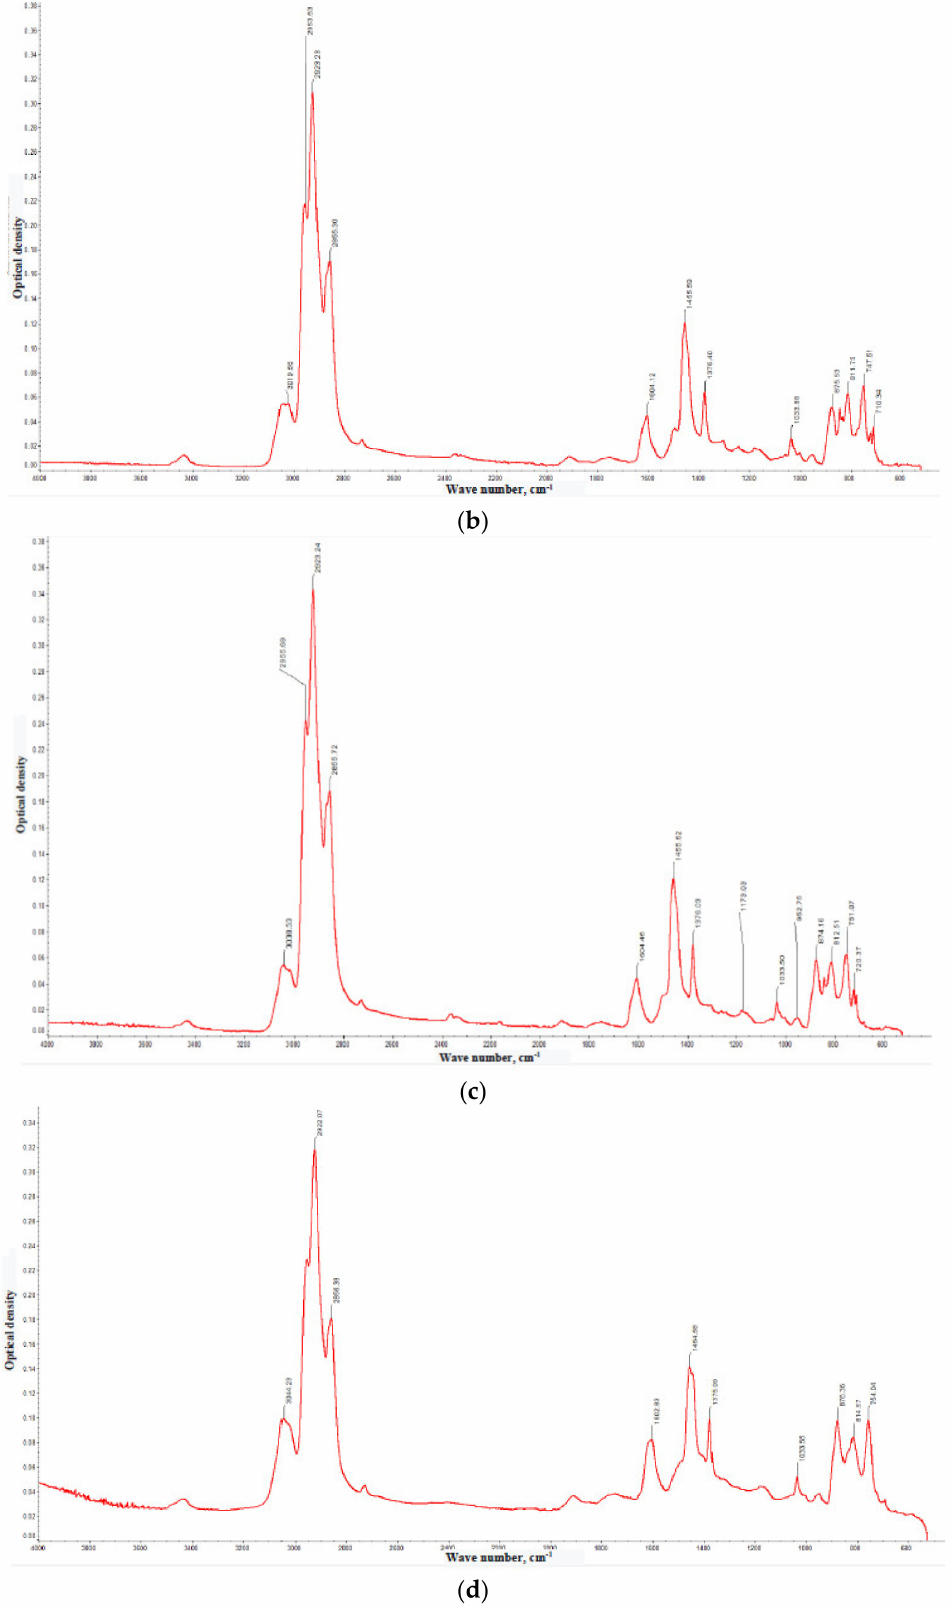
Figure 3. IR spectra of the gasoil fractions with boiling points: <350 ◦ C ( a ), 350–400 ◦ C ( b ), 400–450 ◦ C ( c ), and >450 ◦ C ( d ). The comparison of the optical densities at the characteristic IR bands are collected in Table